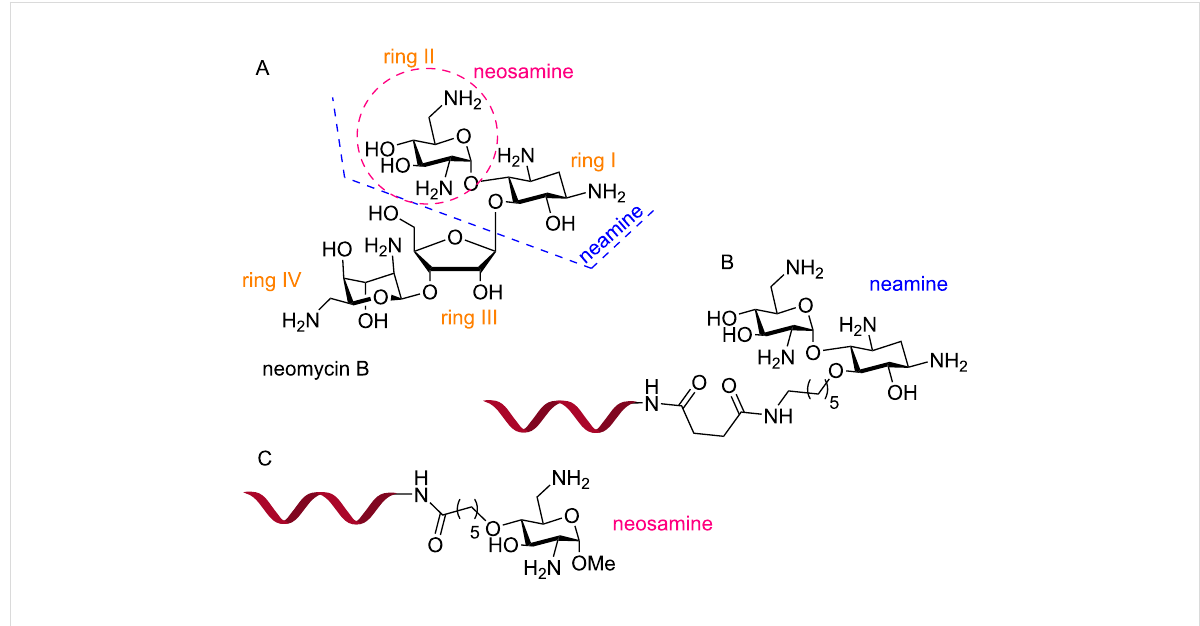
Figure 20: Structures of (A) neomycin B, (B) PNA–neamine conjugate, and (C) PNA–neosamine